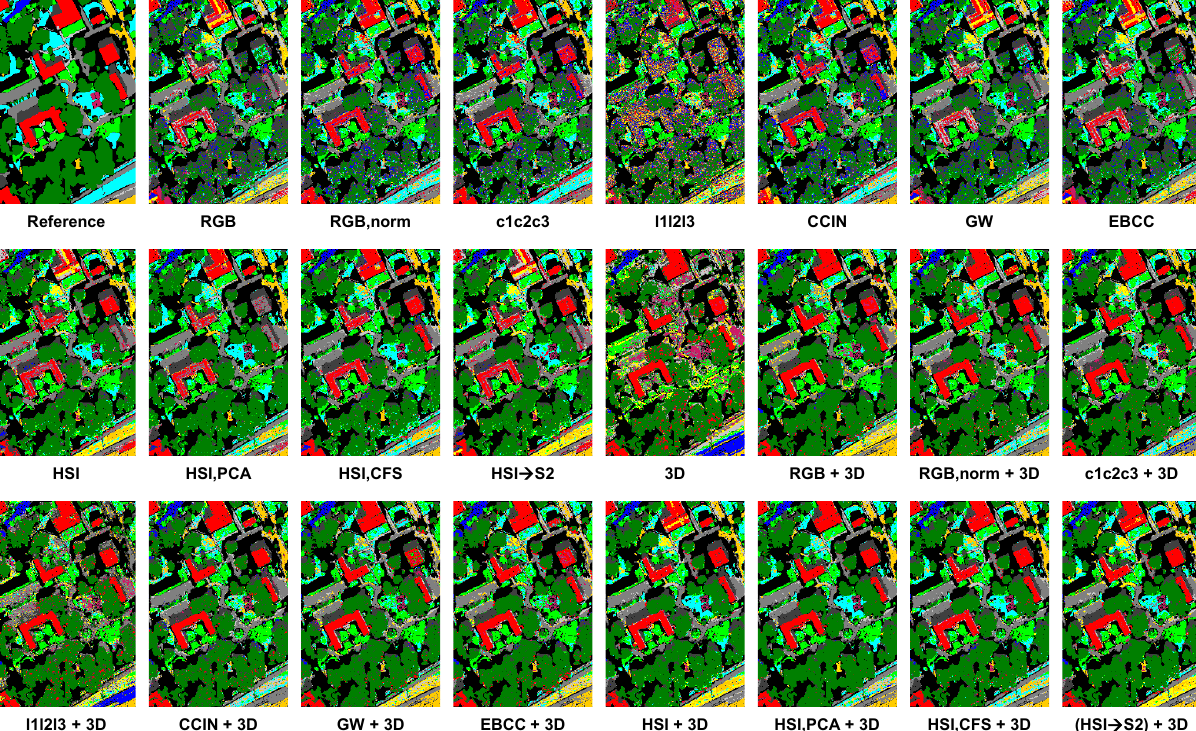
Figure 4. Reference labeling and the classification results achieved for different feature sets and their combination. space ( S l ) does not seem to be appropriate for the given 1 l 2 l 3 classification